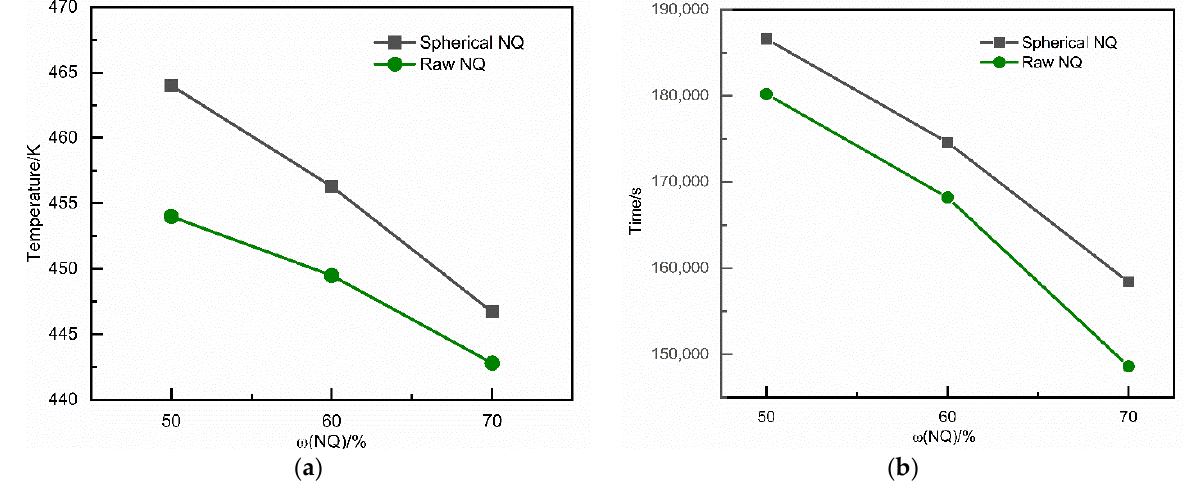
Figure 9. Comparison of slow cook-off results of NQ-based melt-cast explosives with different charge formulations ( a ) Ignition temperature; ( b ) Ignition time.